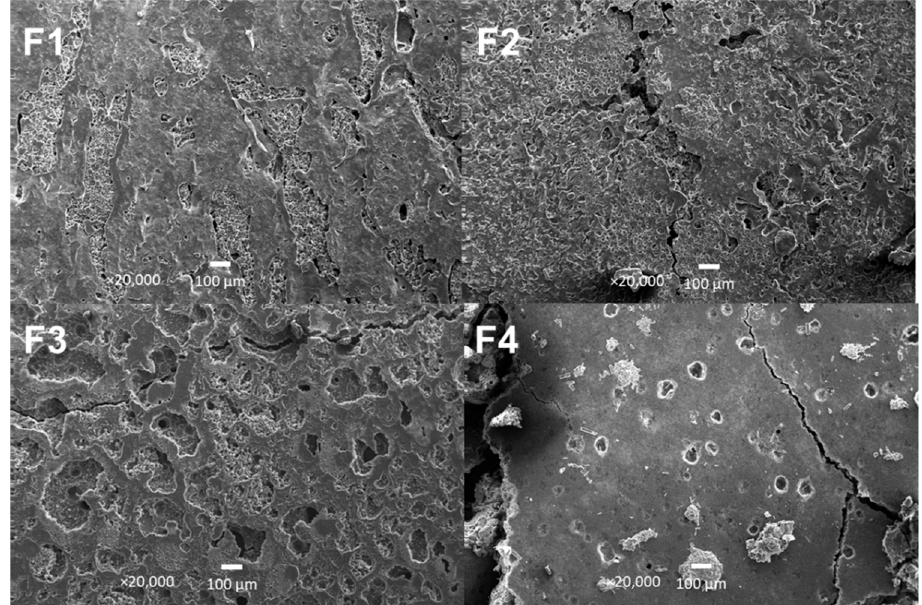
Figure 9. Morphology of PCL/PLA/ZnO-NPs/Gly/TTEO nanocomposites by SEM. F1, 25%PCL/70%PLA/5%Gly at 20,000×; F2, 22%PCL/70%PLA/5%Gly/3%ZnO-NPs at 20,000×; F3, 15%PCL/70%PLA/5%Gly/10%TTEO at 20,000×; F4, 17%PCL/70%PLA/5%Gly/3%ZnO-NPs/10%TTEO at 20,000×.